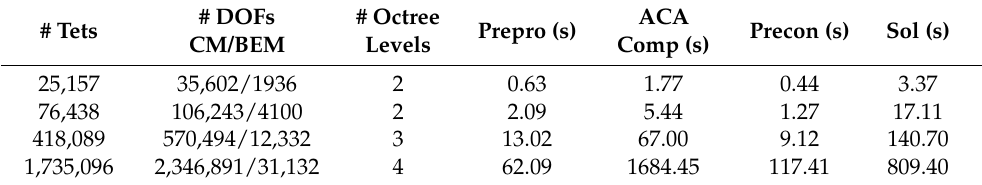
Table 1. Computation times for the CM-BEM software with ACA compression (prepro: preprocessing,